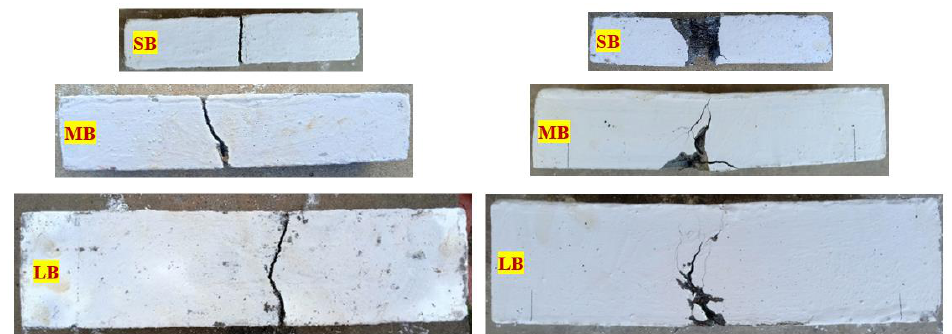
Figure 15. Failure mode of PAFC beams.